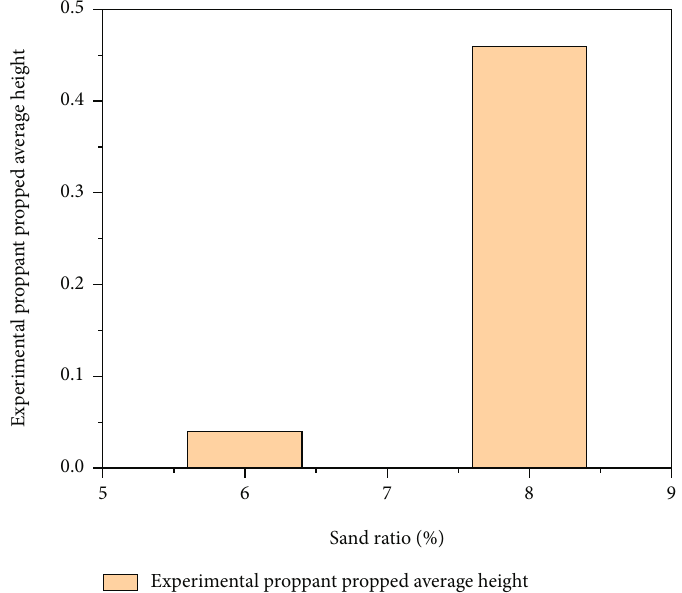
Figure 7: Comparison of 40/70 mesh quartz sand placement results with di ff erent sand